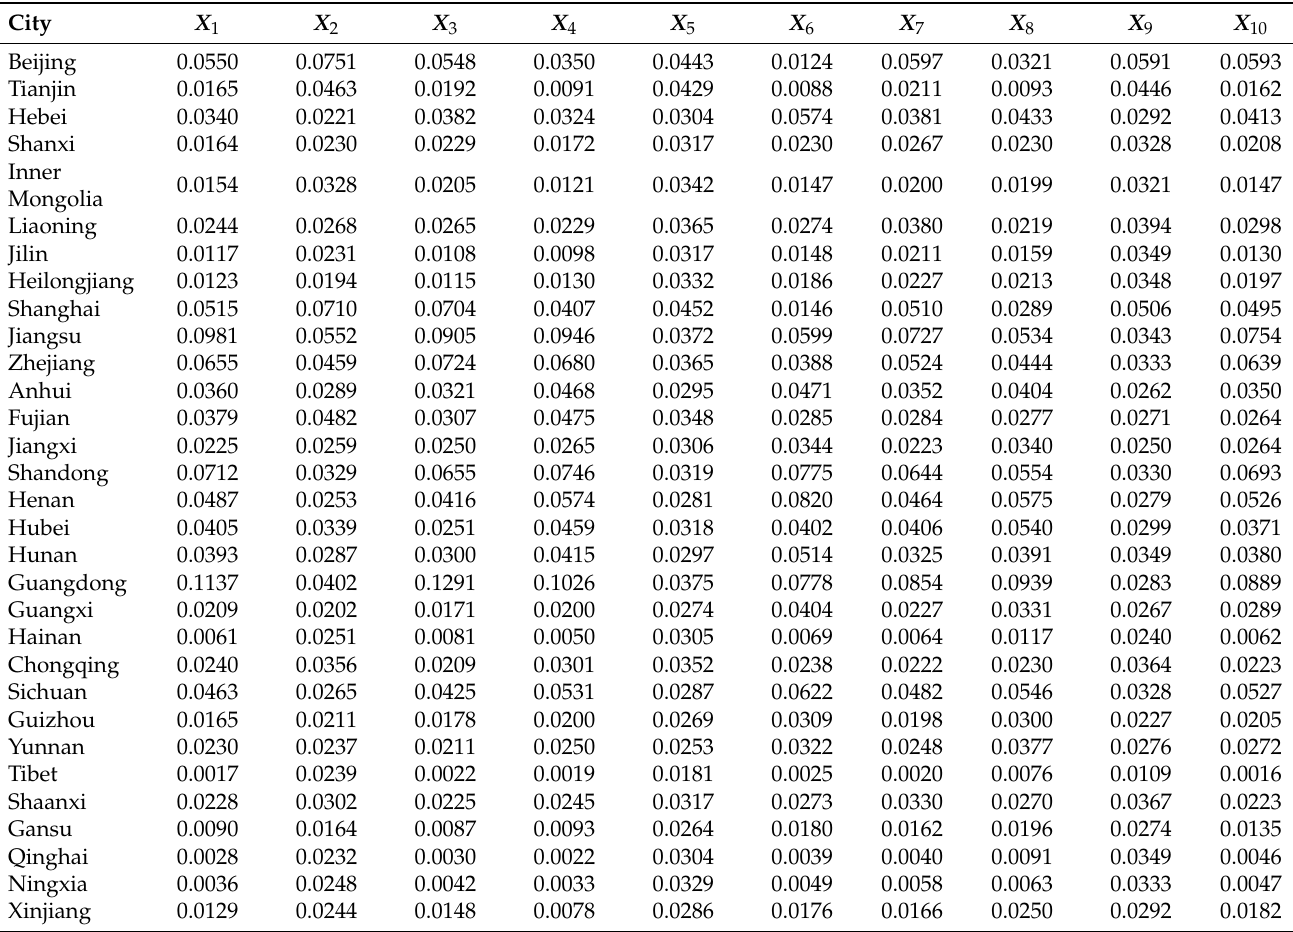
Table A2. Independent variable data based on sum standardization method in